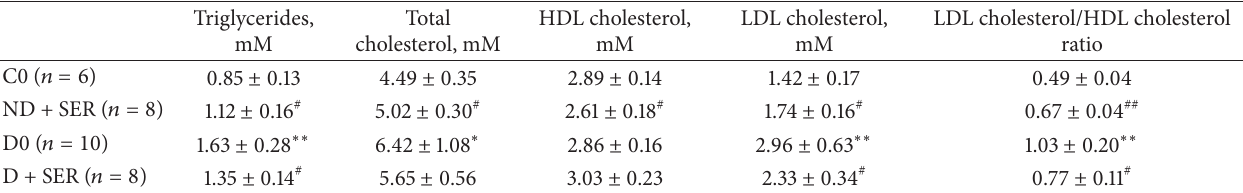
Table 2: The triglycerides, total cholesterol, LDL and HDL cholesterol levels, and ratio of LDL/HDL cholesterol in diabetic and control rats on the 150th day of experiment and the influence of the treatment with IS.